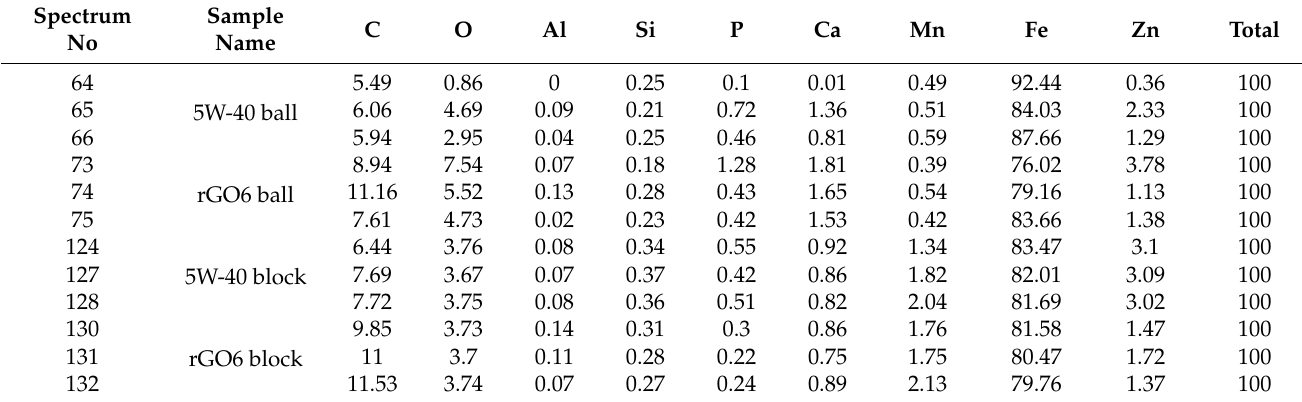
Table 3. An overview of the elemental analysis of the wear scar of the rubbing parts by EDS.